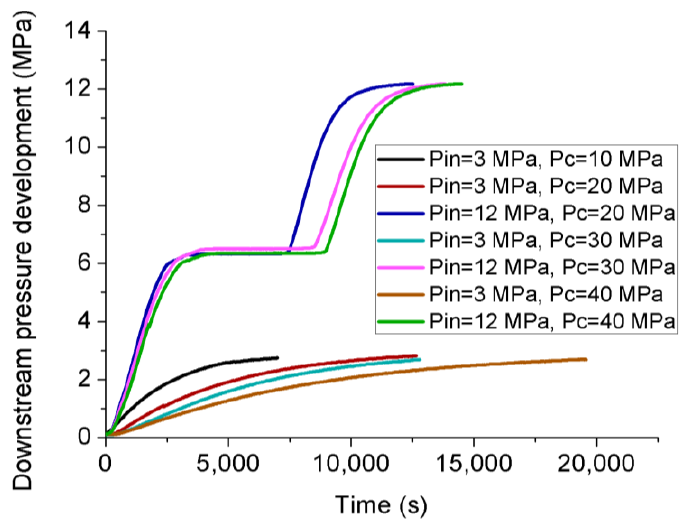
Figure 23. Measurement of downstream fluid pressure for CO 2 injection under 3 MPa injection pressure without phase transition and under 12 MPa injection pressure with phase transition (for the effect of confining pressure).